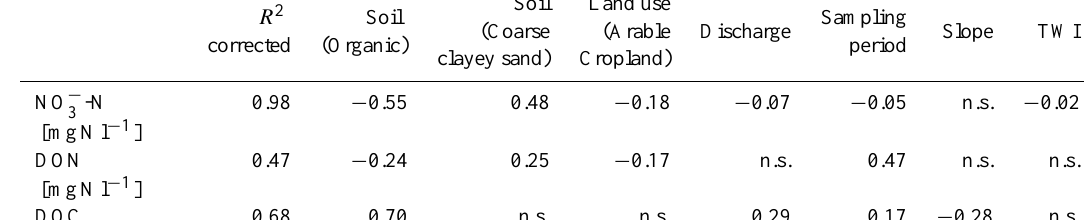
Sampling Slope TWI period